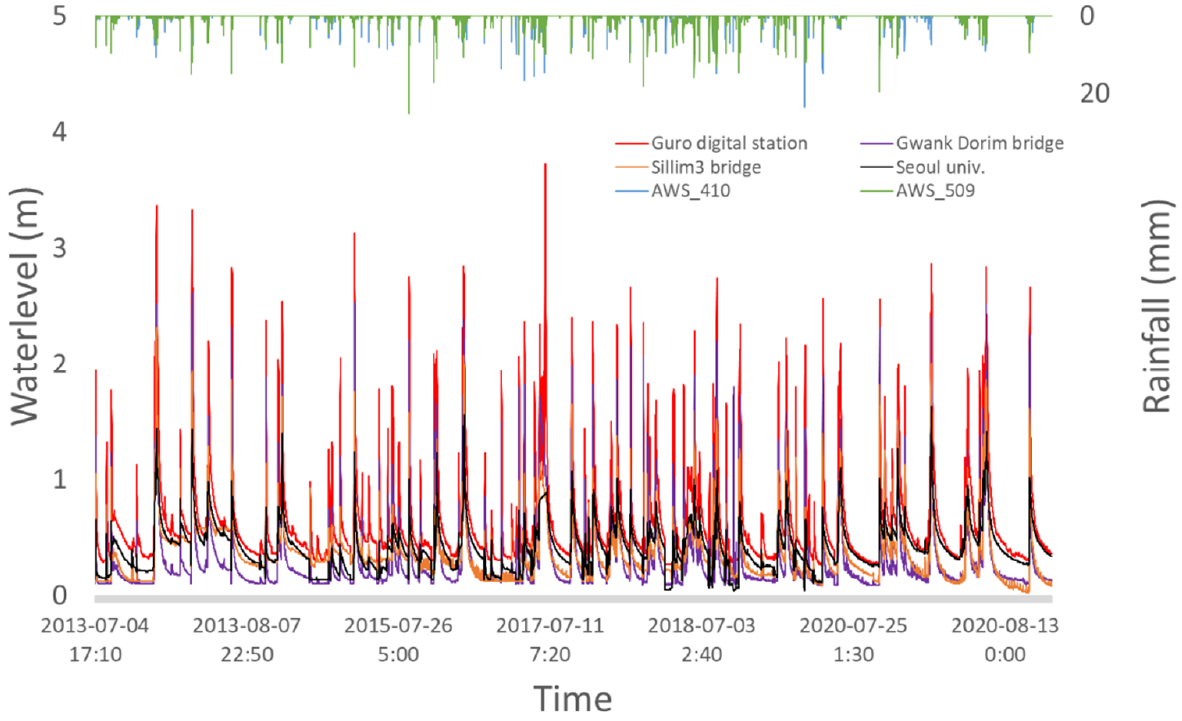
Figure 9. Construction of hydrological time series data.